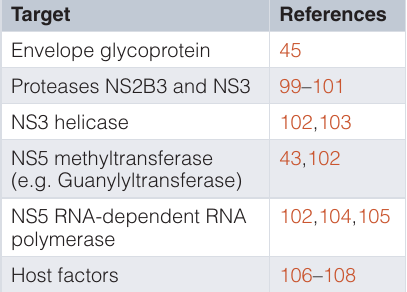
Table 3. Targets in Zika virus with homology to dengue virus.